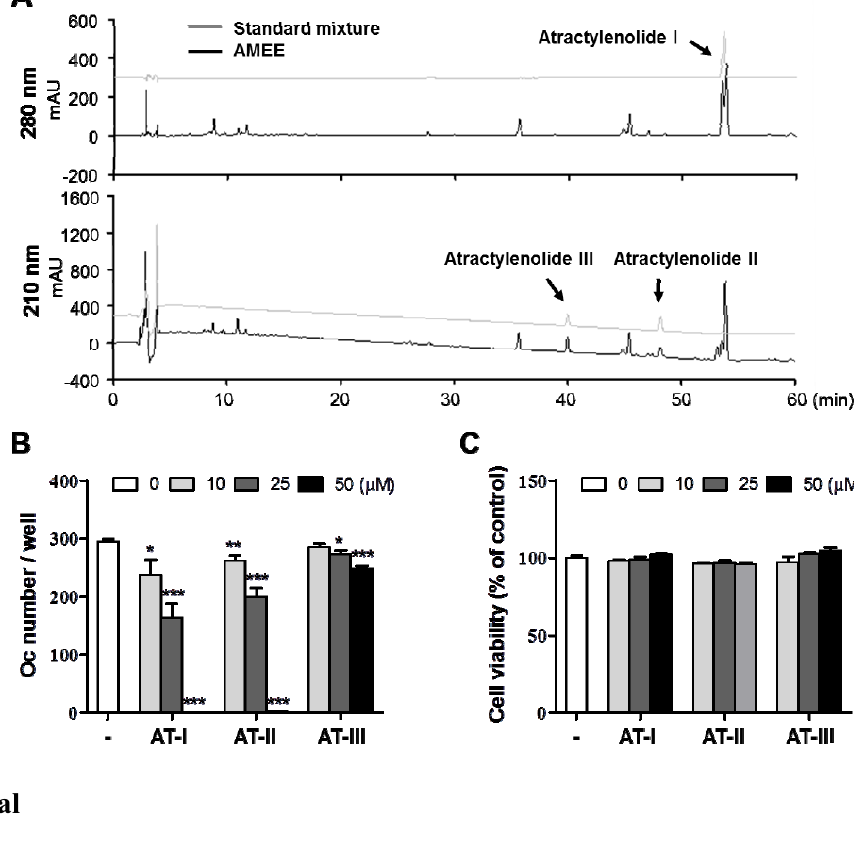
Figure 6. Phytochemical profile of AMEE and the anti-osteoclastogenic effects of atractylenolides. ( A ) HPLC chromatograms of a standard mixture of atractylenolide I, II, and III and AMEE at 210 and 280 nm. ( B ) BMMs were cultured with vehicle (DMSO) or atractylenolide I (AT-I), II (AT-II), and III (AT-III) in the presence of M-CSF (60 ng/mL) and RANKL (100 μ g/mL) for 4 days. TRAP-positive multinucleated cells containing more than three nuclei were counted as osteoclasts. * p < 0.05; ** p < 0.01; *** p < 0.001 versus vehicle-treated control. ( C ) Effects of atractylenolide I, II, and III on the viability of BMMs were determined by CCK-8